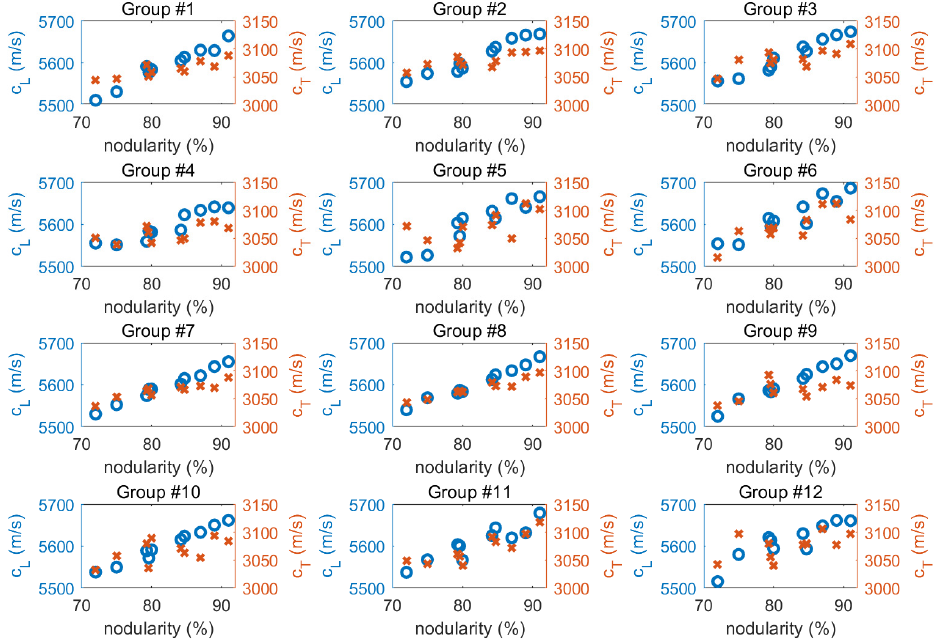
Figure 3. (Color Online) Raw experimental data collected in the first week from ultrasonic measure- ments under different conditions. The longitudinal wave velocities are represented by blue circles, and the transverse wave velocities are represented by orange crosses.